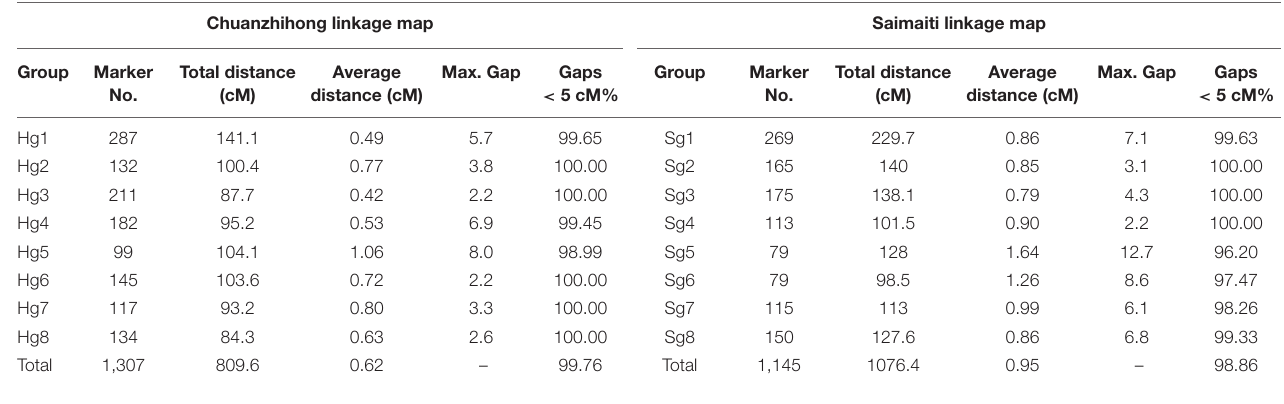
TABLE 3 | Feature of each linkage group of parents in this study. Chuanzhihong linkage map Group Marker